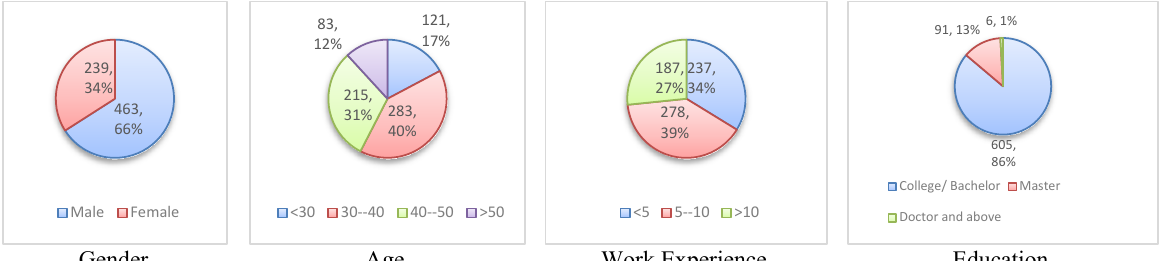
Fig. 1. Personal characteristics of the